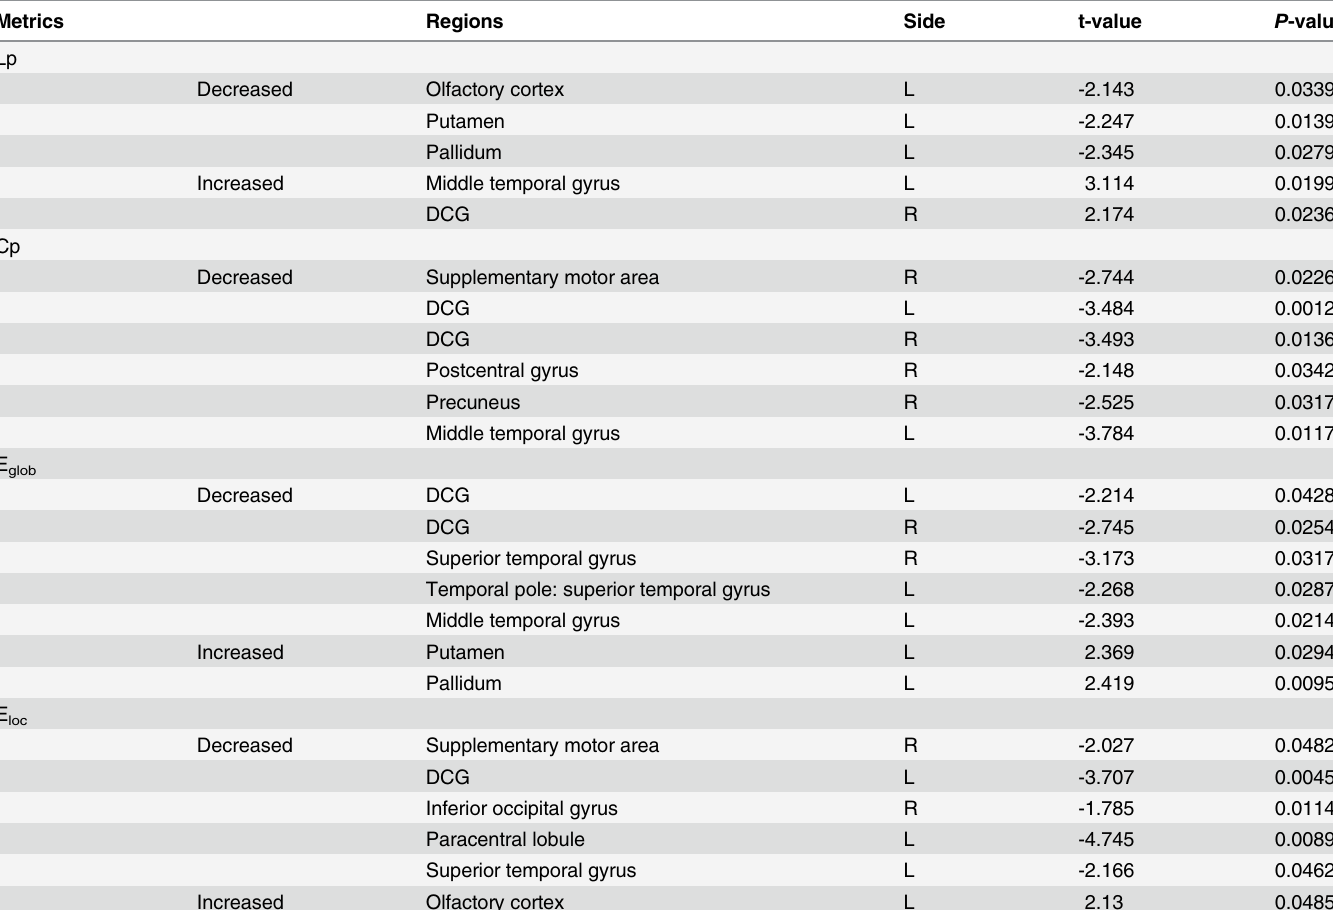
Table 2. Significant differences in all metrics between SVIC patients and controls in the range of 0.05 (cid:1) S thr (cid:1) 0.40.